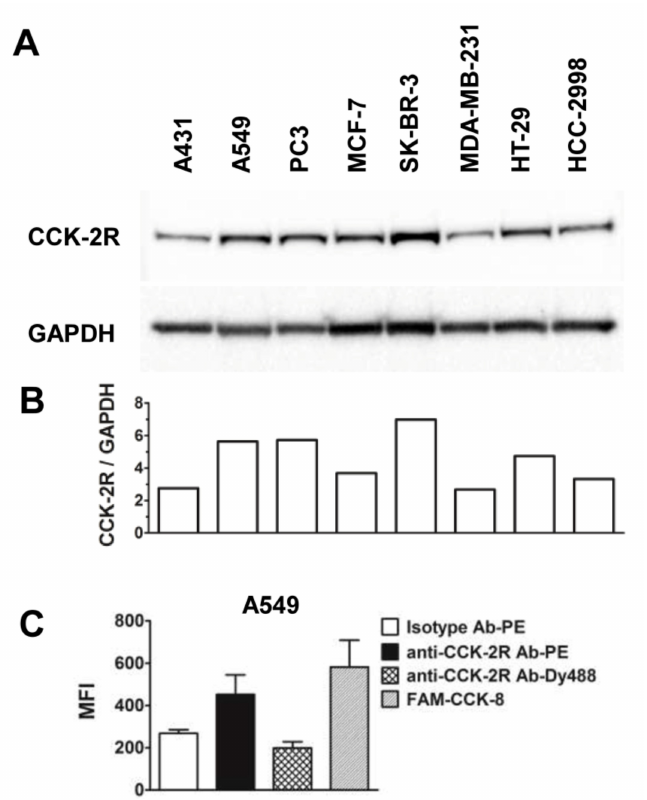
Figure 1. ( A ) Western blot and ( B ) quantification of the total cholecystokinin-2 receptor (CCK- 2R) expression on different cell lines. GADPH served as the loading control for total proteins. ( C ) Levels of CCK-2R expression on cell surface by flow cytometry. Dead cells were removed from the analysis using LIVE/DEAD staining. The fluorescence intensity of control cells stained only with the LIVE/DEAD was subtracted. Mean fluorescence intensity plus SEM of three independent experiments is